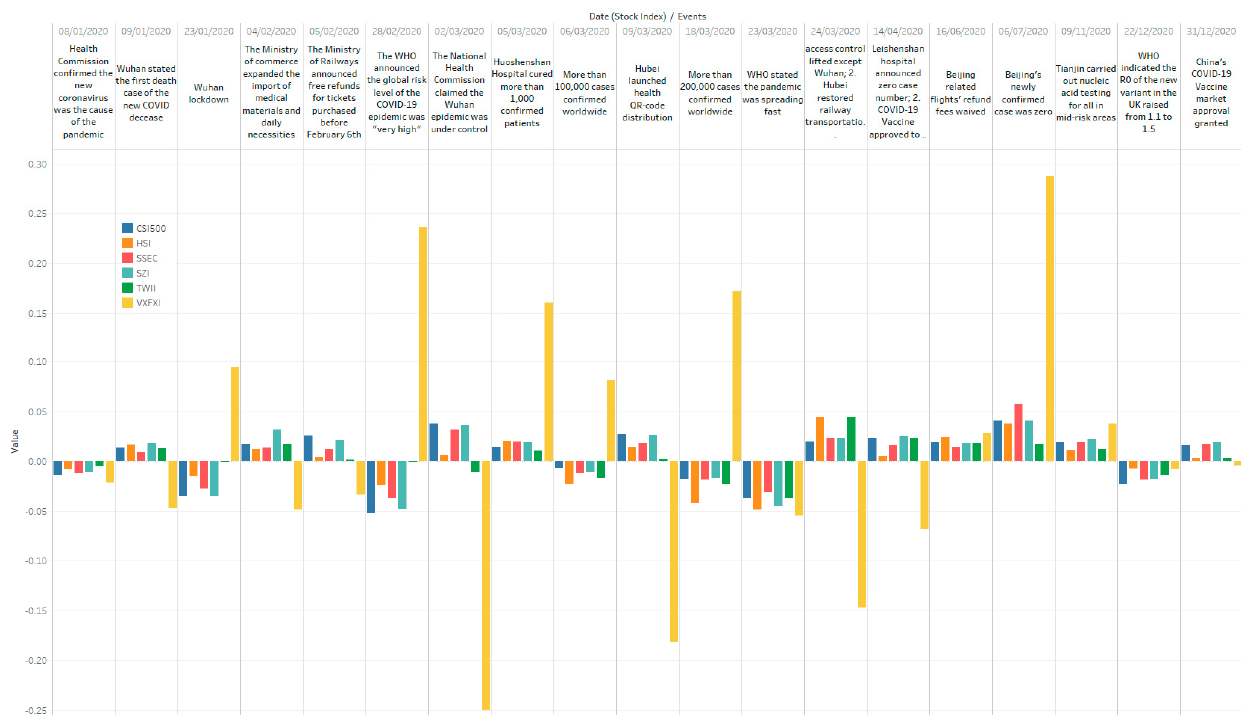
Figure 8. Major social events and stock market trends in 2020 in China (bar).